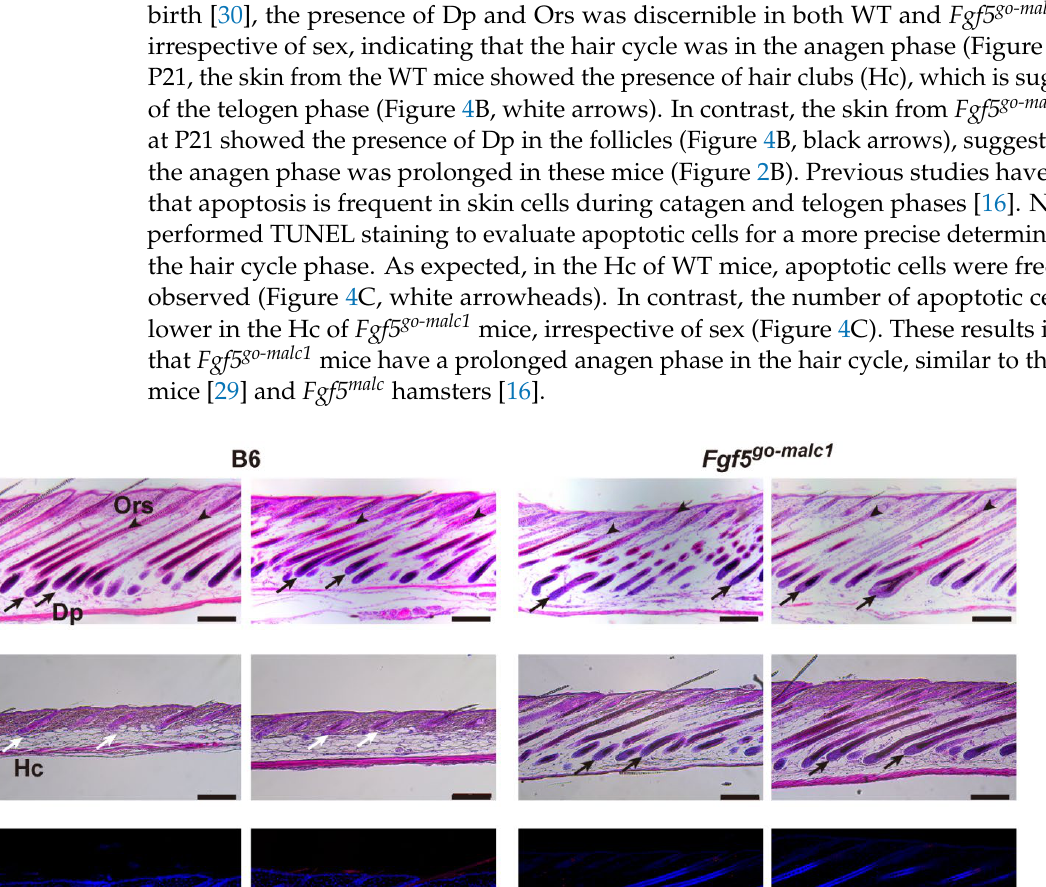
( B ) Relative expression of Fgf5 (upper graphs) and Fgf5s (bottom graphs) transcripts in the skin (left graphs) and brain (right graphs) of C57BL/6J (B6) and Fgf5 go-malc1 mice. Black and gray bars indicate values of relative expression levels of Fgf5 and Fgf5s transcripts in B6 and Fgf5 cr mice, respectively ( n = 3; geometric means ± standard deviation). n.s.: no significant differences. ( C ) Immunohisto- chemical localization of FGF5 protein (red) in the skin of B6 (upper panels) and Fgf5 go-malc1 mice (bottom panels). Nuclei were counterstained with DAPI (blue). Arrows and arrowheads indicate the dermal papilla (Dp) and outer root sheath (Ors) in the hair follicles, respectively. Scale bar = 100 µ m.